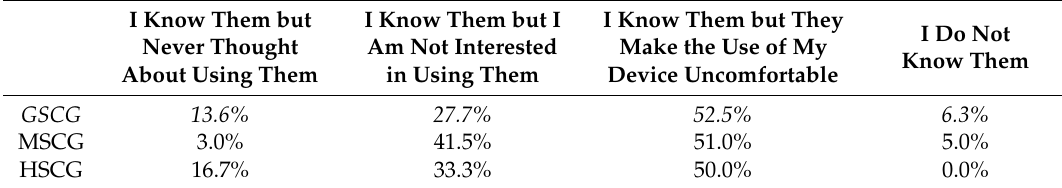
Table 10. If you do not use a mechanism to protect access to your mobile device, why is that